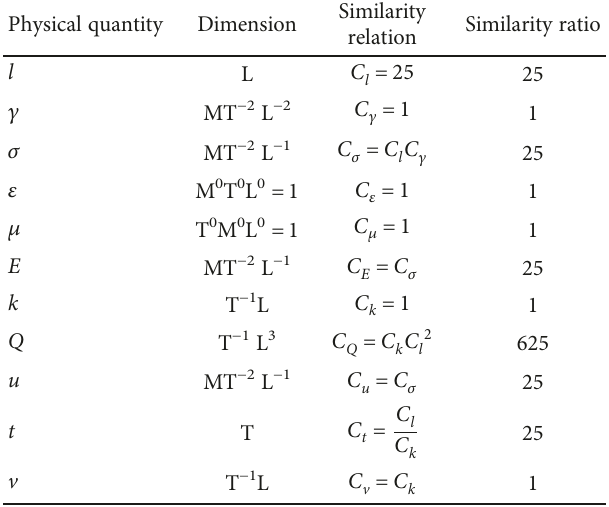
Table 1: Similarity ratios of physical quantities. Physical quantity